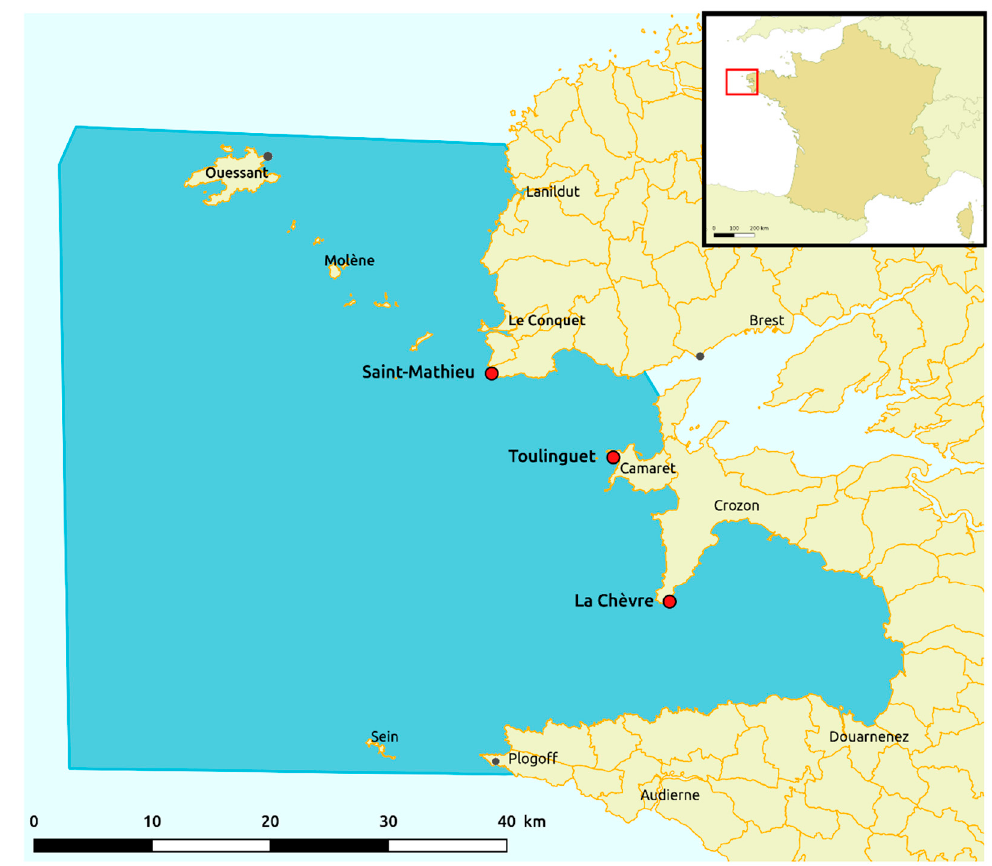
Figure 3. The Iroise Sea. In red, the sémaphores considered in the present work; in grey, the other sémaphores of the study area.